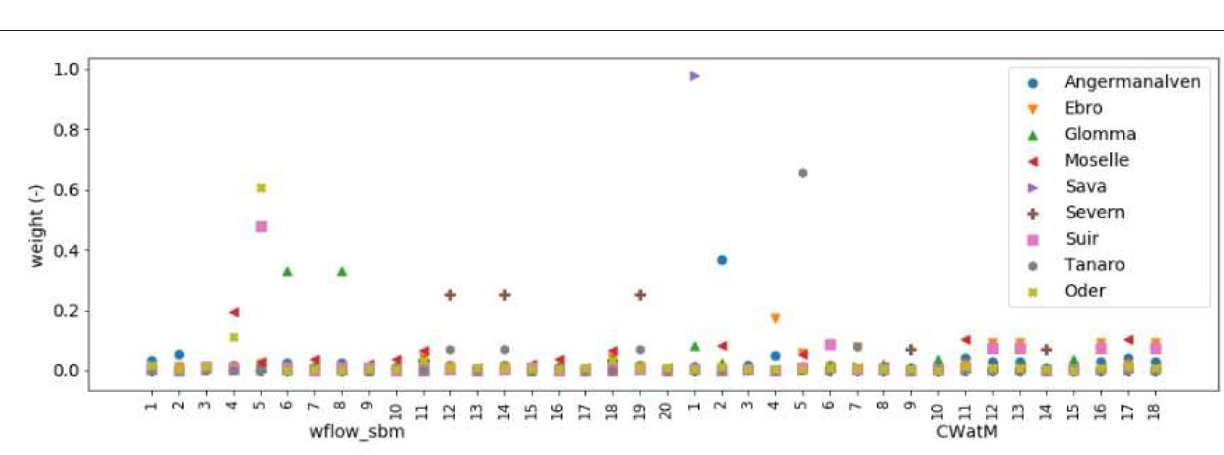
FIGURE 6 | Projected future changes in annual mean discharge based on the full set of realizations - Unweighted ALL (blue), the Reliability Ensemble Averaging method – REA (orange), the realizations available for CWatM and LISFLOOD – Unweighted CWAtM, wflow_sbm (green) and ClimWIP (red) for the nine selected river basins. Together with the 5 and 95% uncertainty bounds of the full ensemble (blue